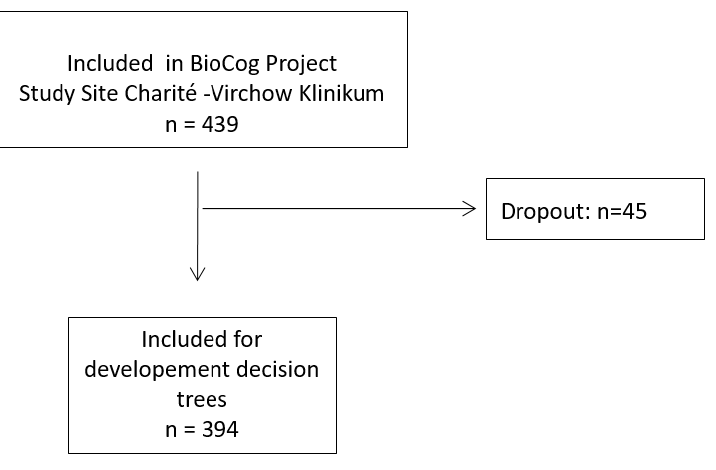
Figure 1. Flow Figure 1. Flow chart.